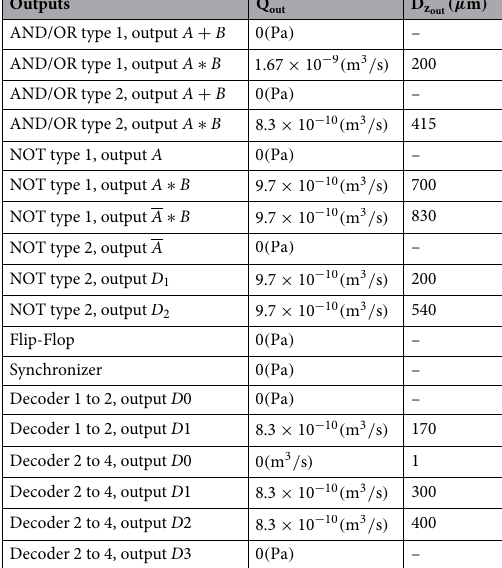
Table 6. Output flow rate and entrance length for each output branch.